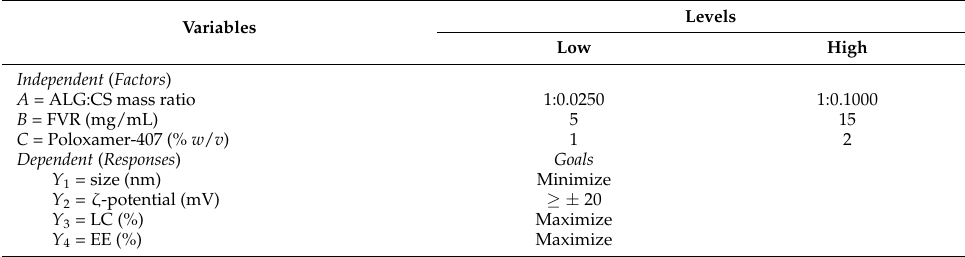
Table 1. Investigated variables used in BBD.